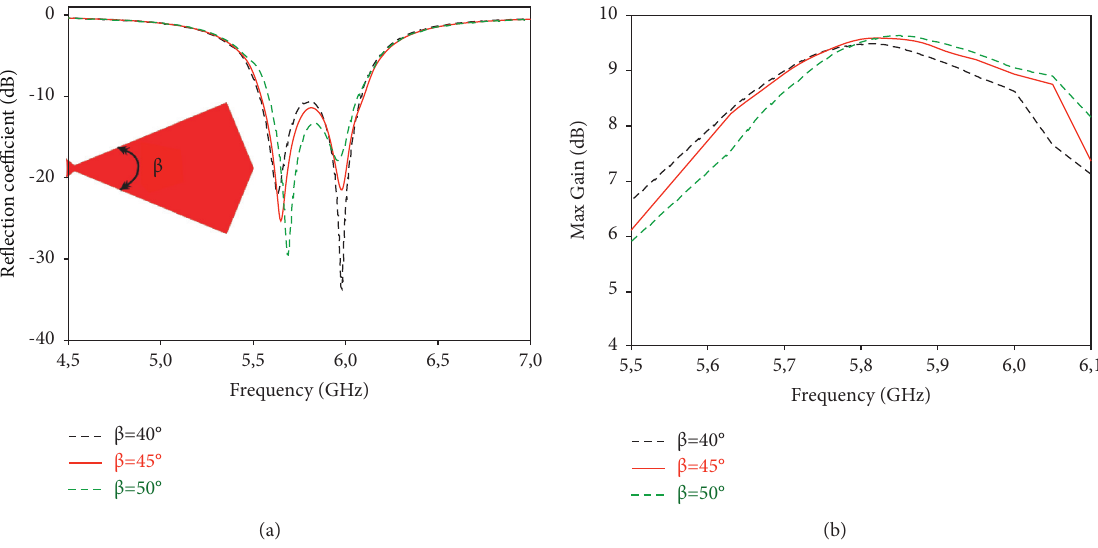
Figure 6: Reflection coefficient (a) and gain (b) for different angles ( ß